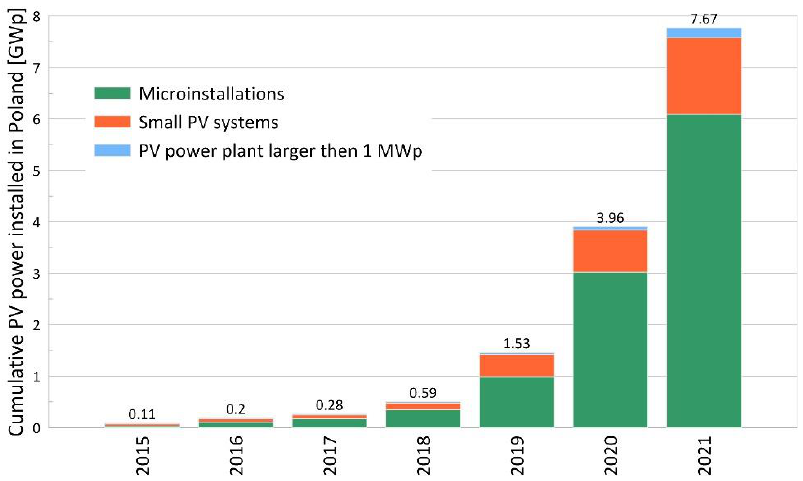
Figure 1. Cumulative photovoltaic power installed in Poland [1].